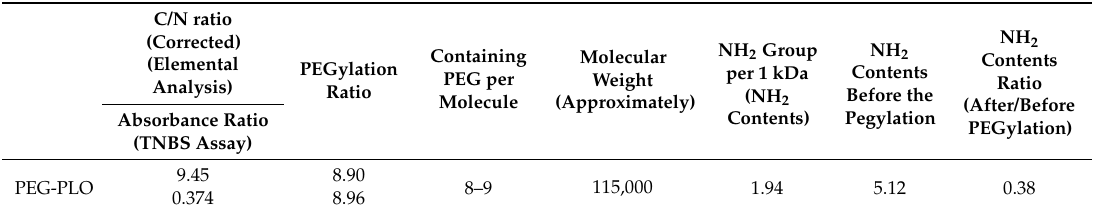
Table 2. Physical properties of PEG-PLO obtained, and elemental analysis calculated through the TNBS assay.